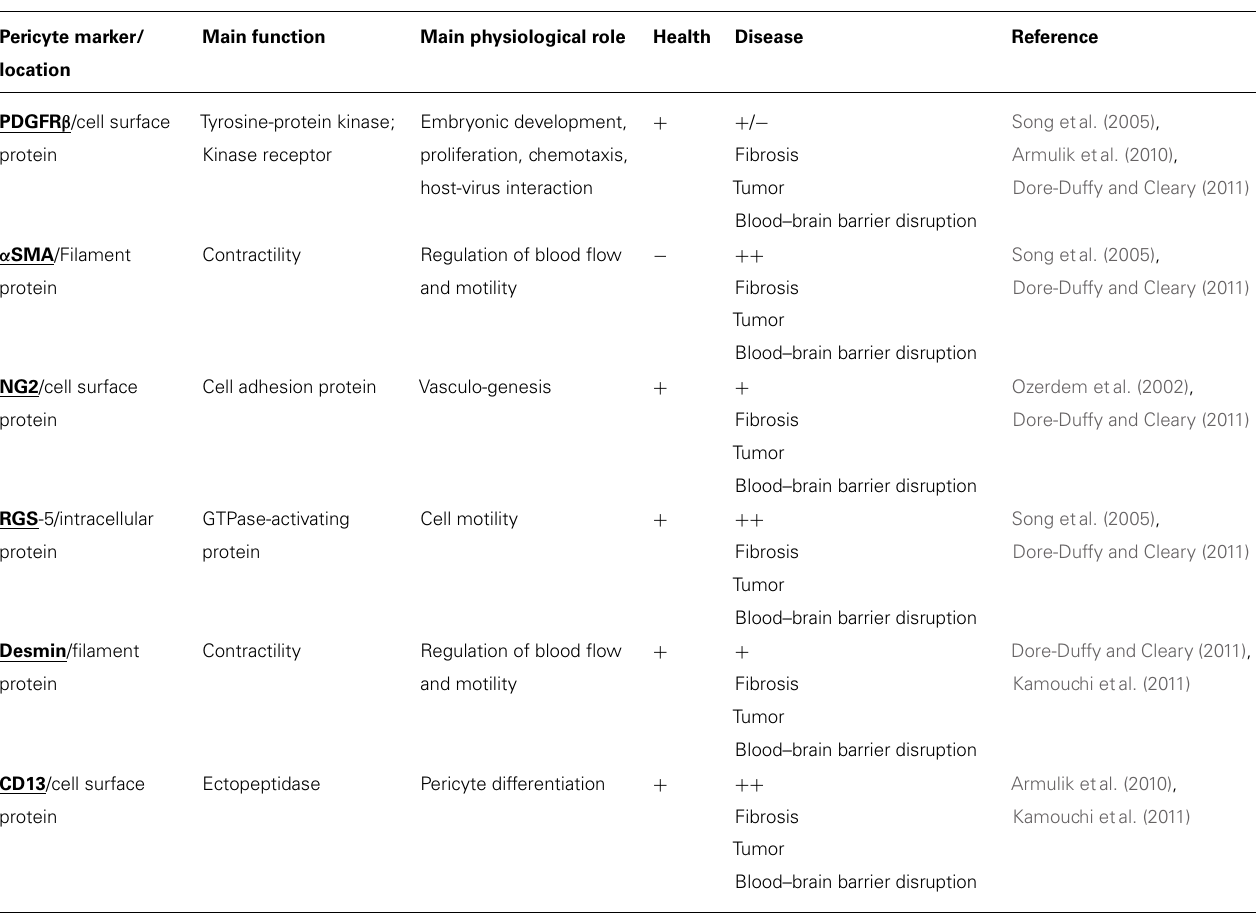
Table 1 | Pericyte markers in health and disease.